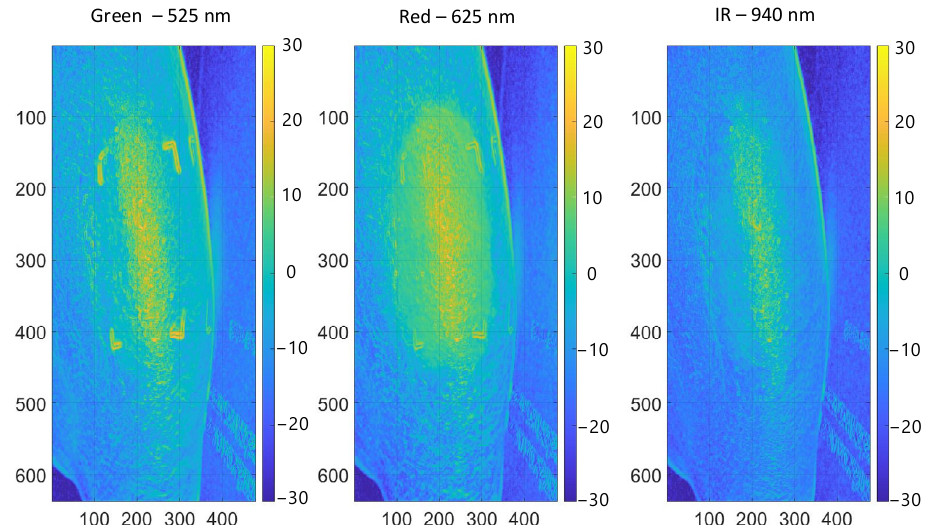
Figure 18. Amplitude AC maps, 3- λ mode.